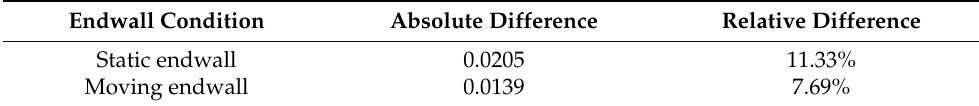
Table 2. Differences in averaged total pressure loss between the experiment and